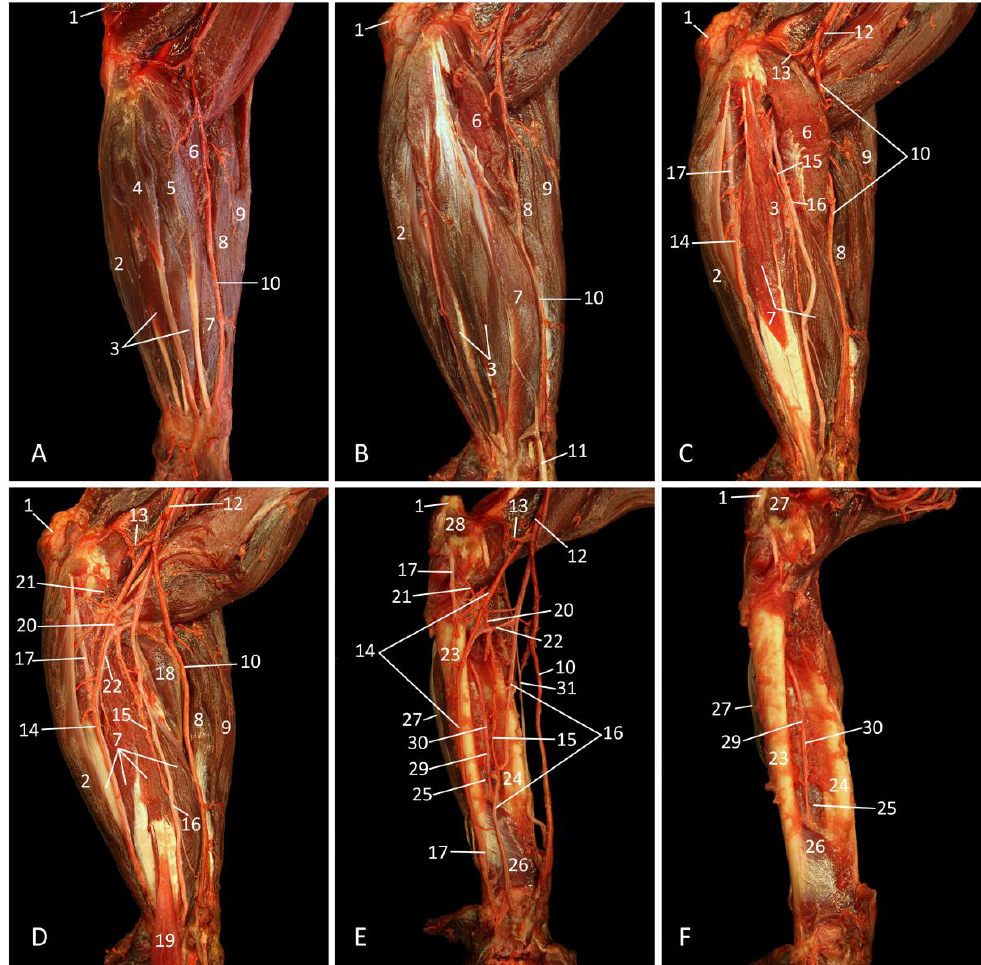
Figure 9. Medial view of the left forearm; the arterial system is filled with red latex. ( A ): Superficial layer; ( B ): Second layer, after the m. flexor carpi radialis has been retracted and the m. palmaris longus was removed; ( C ): Third layer, after partial resection of the m. flexor digitorum superficialis; ( D ): Fourth layer, after the total resection of the m. flexor digitorum superficialis and the m. pronator teres; ( E ): Fifth layer, after amputation of the m. brachioradialis, the m. extensor carpi radialis longus, the m. flexor carpi ulnaris, and the m. flexor digitorum profundus; ( F ): Deepest layer, after the removal of the majority of blood vessels and nerves.